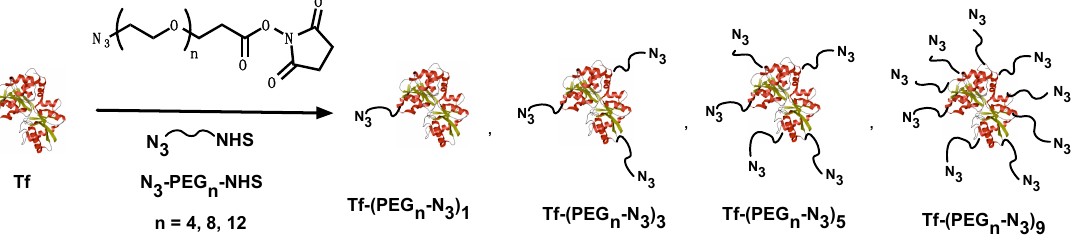
Figure 1. Transferrin (Tf) functionalization with PEG linkers of different sizes (4, 8, and 12 units) and in different Tf to linker ratios (1:1, 1:3, 1:5, and 1:9).